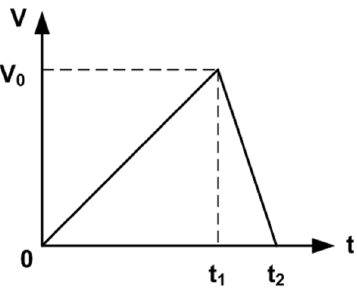
Figure 4. The waveform of the input voltage. The duty ratio is de- fined as t 1 /t 2 and it is 75 and 80%, respectively, in this study; V 0 is the maximum voltage.